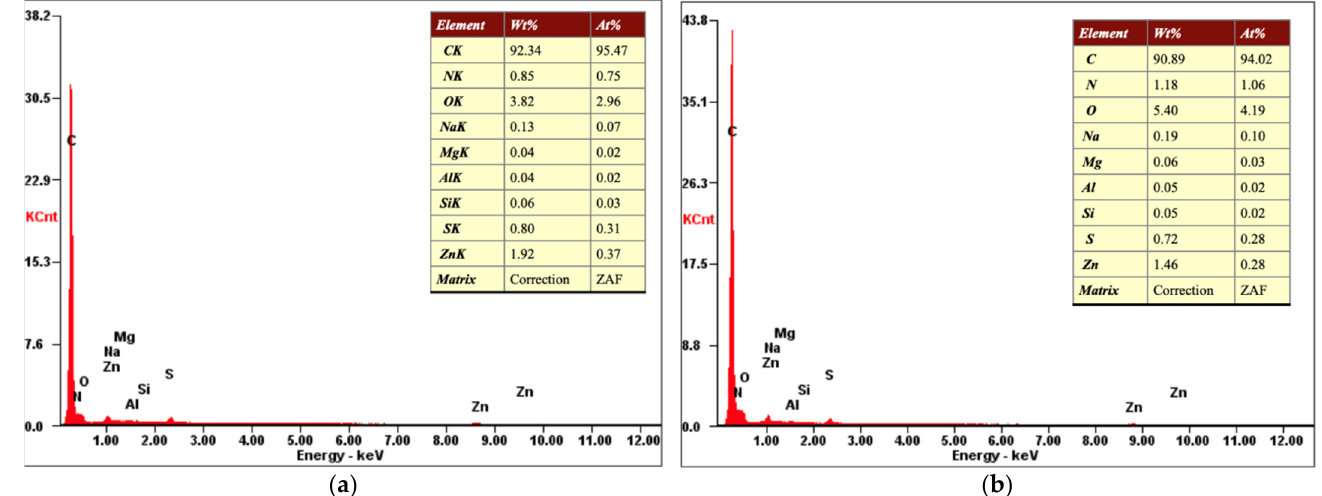
Figure 10. Elemental composition of crumb rubber before ( a ) and after ( b ) cryogenic destruction.